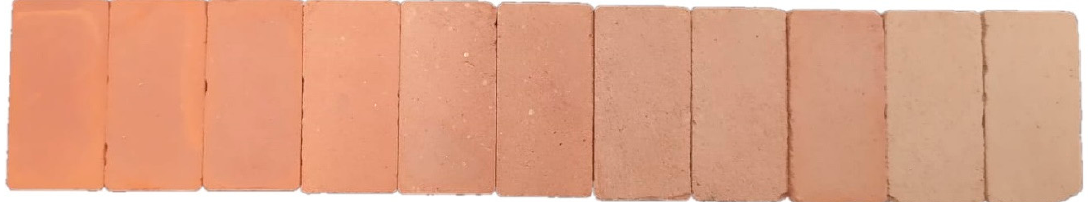
Figure 4. Image of a sample of each family of ceramics made from stone cutting sludge. From left to right, 0S10C, 1S0C, 2S8C, 3S7C, 4S6C, 5S5C, 6S4C, 7S3C, 8S2C, 9S2C, and 10S0C.